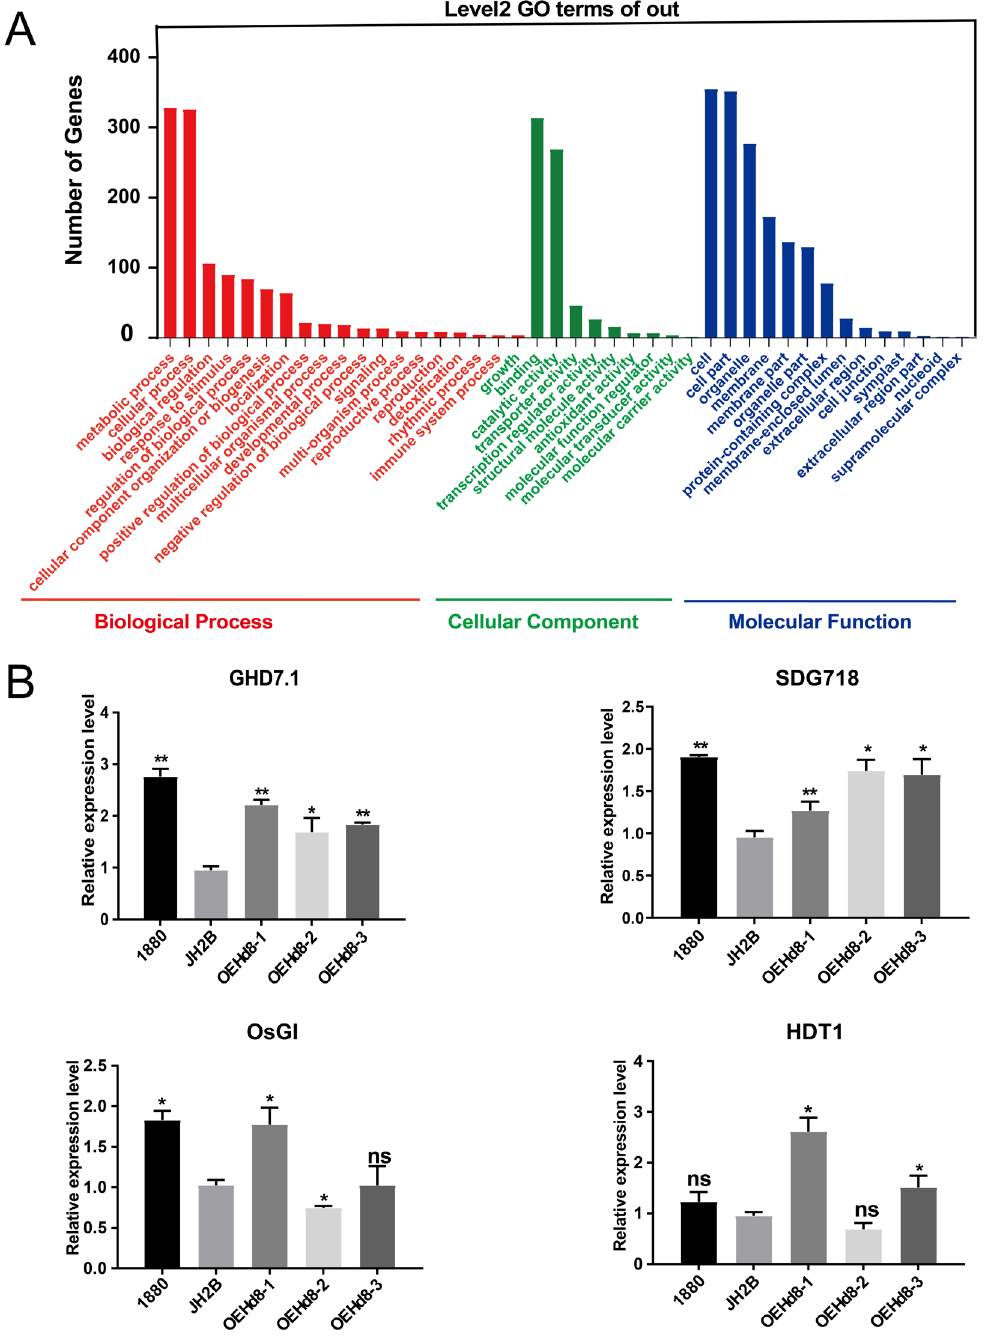
Figure 6. Transcriptome analysis of the DEGs from RNA-sequencing data in heading date between JH2B and OE-OsHd8. ( A ) Gene ontology (GO) annotation of differentially expressed genes (DEG) in heading date between JH2B and OE-OsHd8. The enriched GO terms of molecular function, bio-